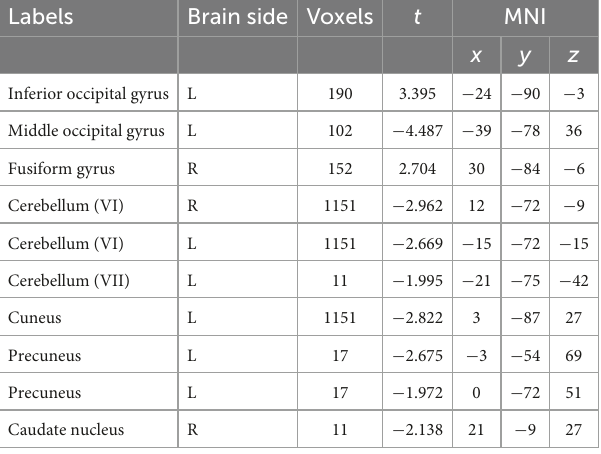
TABLE 1 Clusters of brain activation areas for geometric